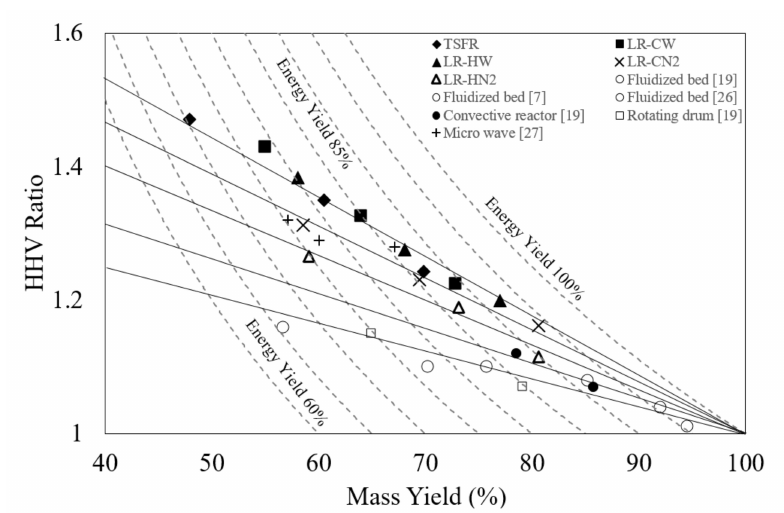
Figure 11. The plot of HHV ratio - mass yield diagram and iso-energy yield